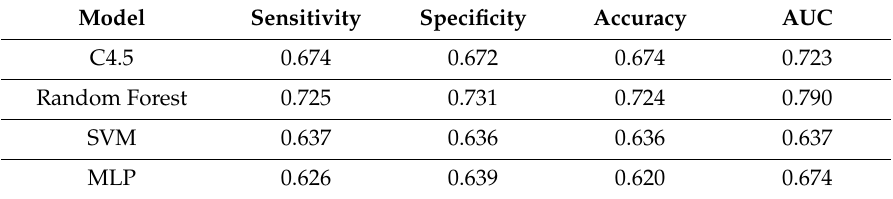
Table 6. The predictive validity of the hip-fracture mortality model.